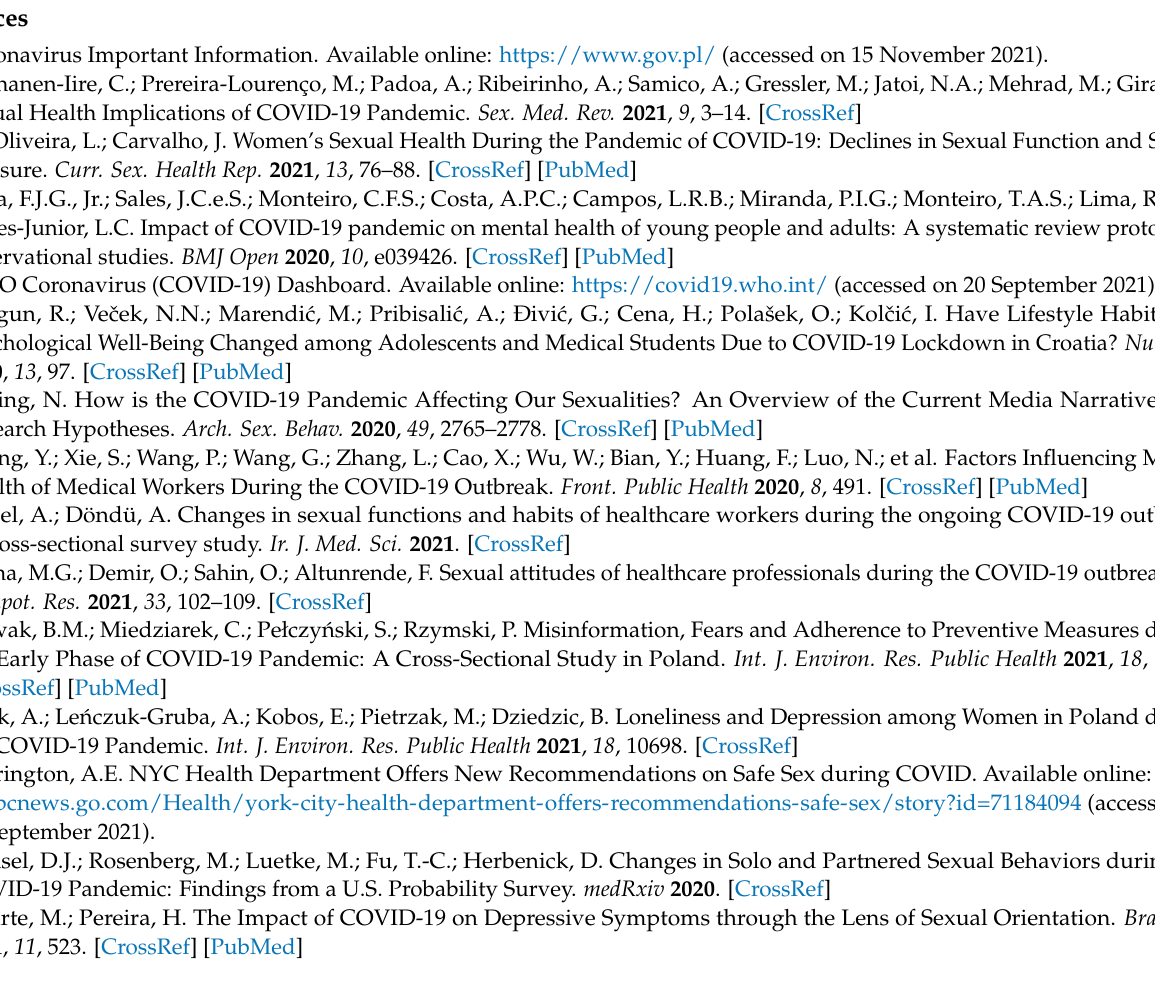
Figure A1. Age difference/distribution and sample size calculation. We estimated the sample size using the G* power package. A priori, we set the Mann–Whitney U test (two groups) with an average effect size of d = 0.50, a power (1- β ) of 0.95, a probability level of α = 0.05 and an allocation ratio of 1/3. With these assumptions, the total study group should have included 244 (61/181) participants. The total study group was 2364 participants (about 10 times more than required), which means it was overpowered. The reason for this is related to the fact that with larger samples, it is easier to show statistical differences between study groups. In this case, those differences were not clinically significant.